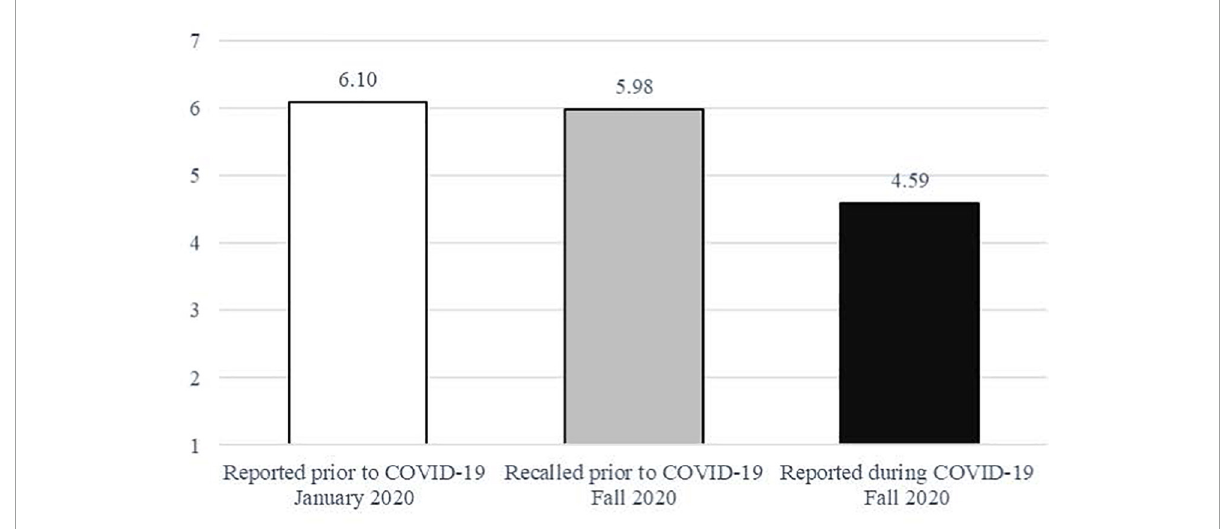
FIGURE1 The average teacher self-reported confidence in their ability to differentiate reported January 2020 prior to the onset of COVID-19 (white), fall 2020 recalled confidence for pre-COVID-19 onset (gray), and fall 2020 reported confidence after COVID-19 onset